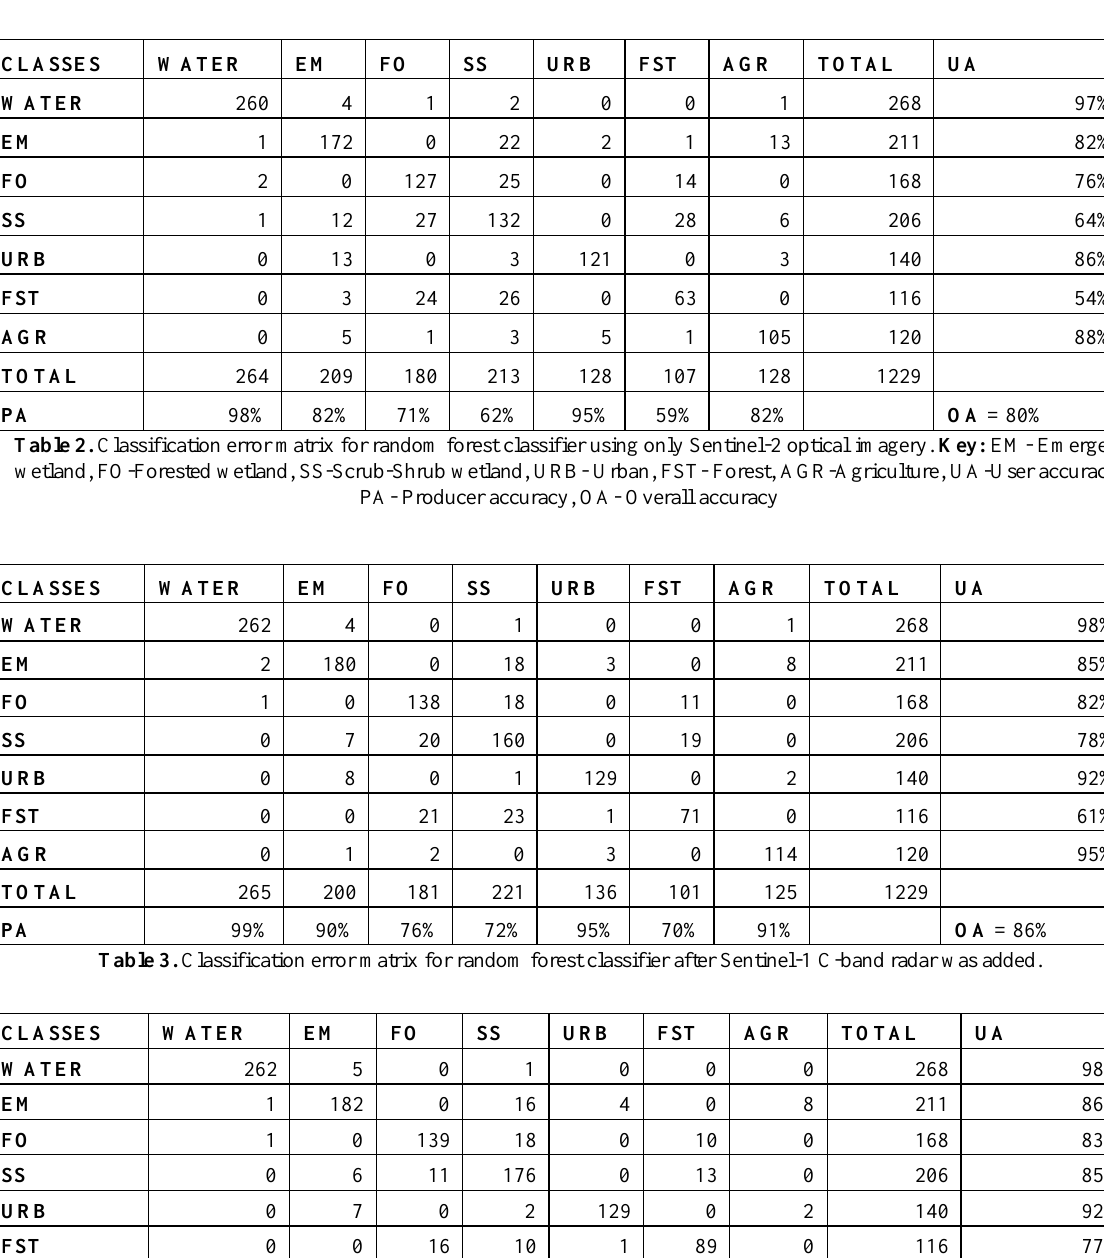
Table 4. Classification error matrix for random forest classifier after DEM and soil datasets were added